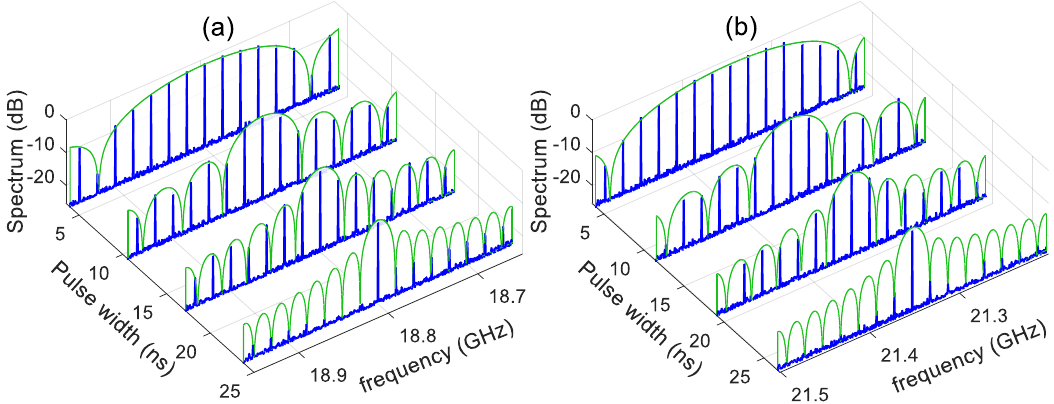
Figure 3. ( a ) The down-conversion simulation spectra as τ arose; ( b ) the up-conversion simulation spectra as τ arose (the blue lines are the discrete longitudinal modes; the green curves are the envelopes of the Sinc function).